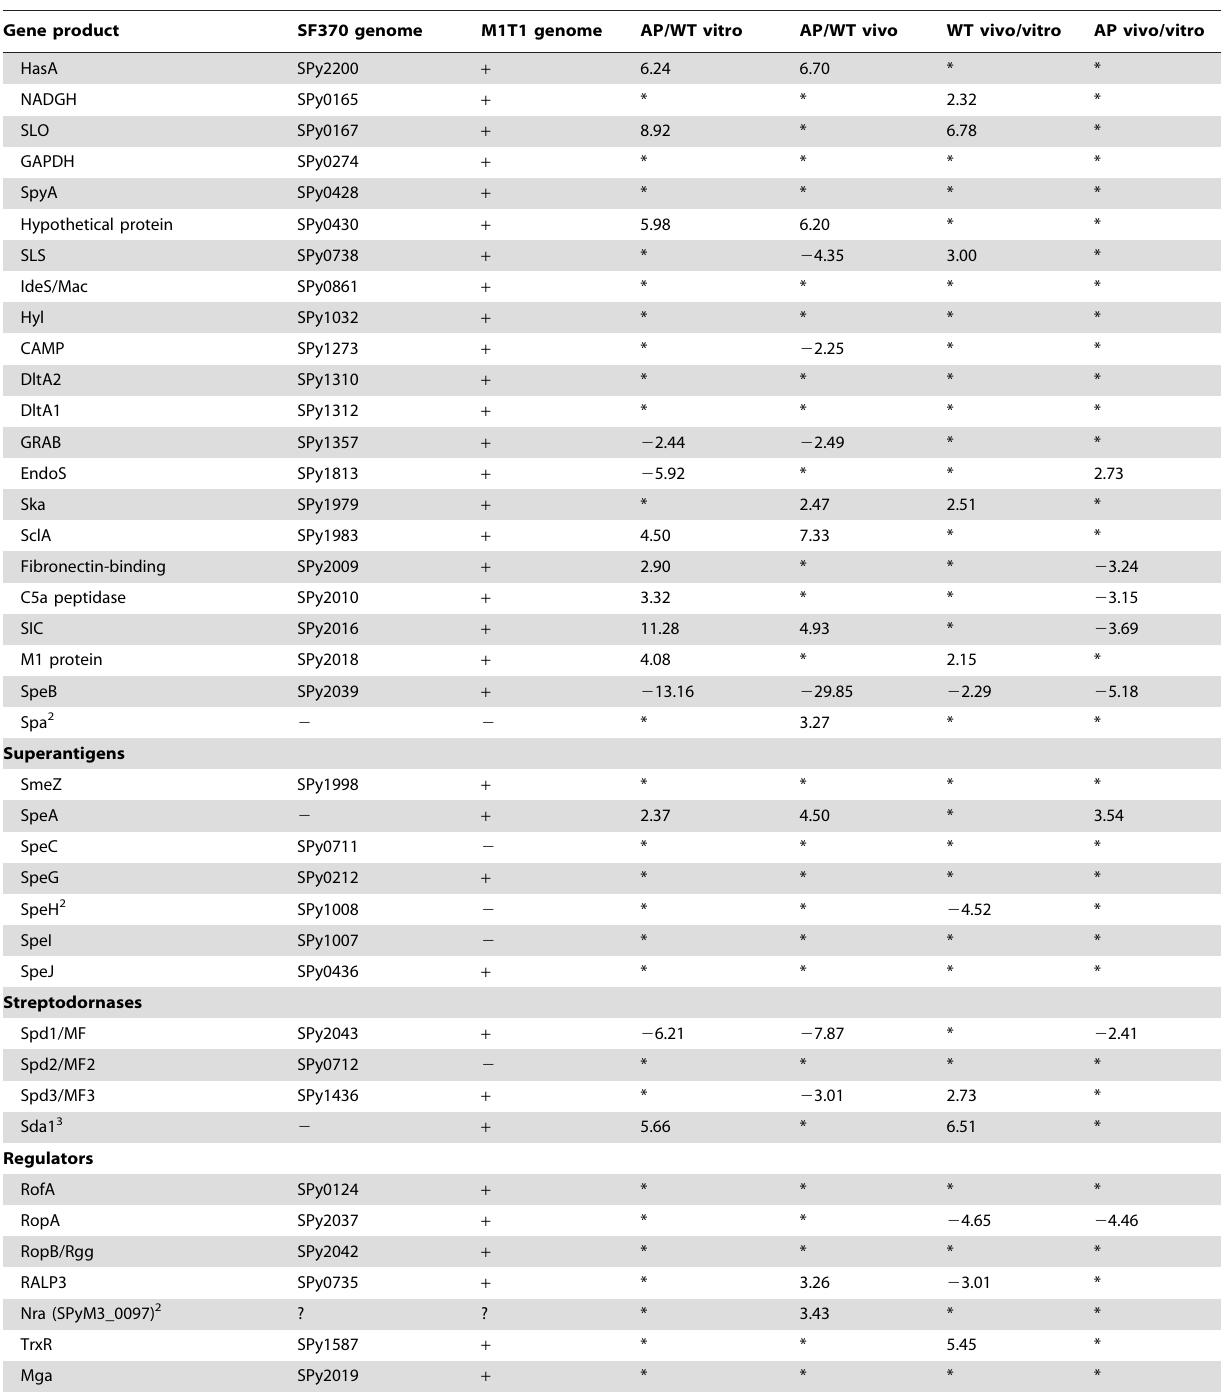
Table 3. Expression ratios of selected virulence genes and regulators 1